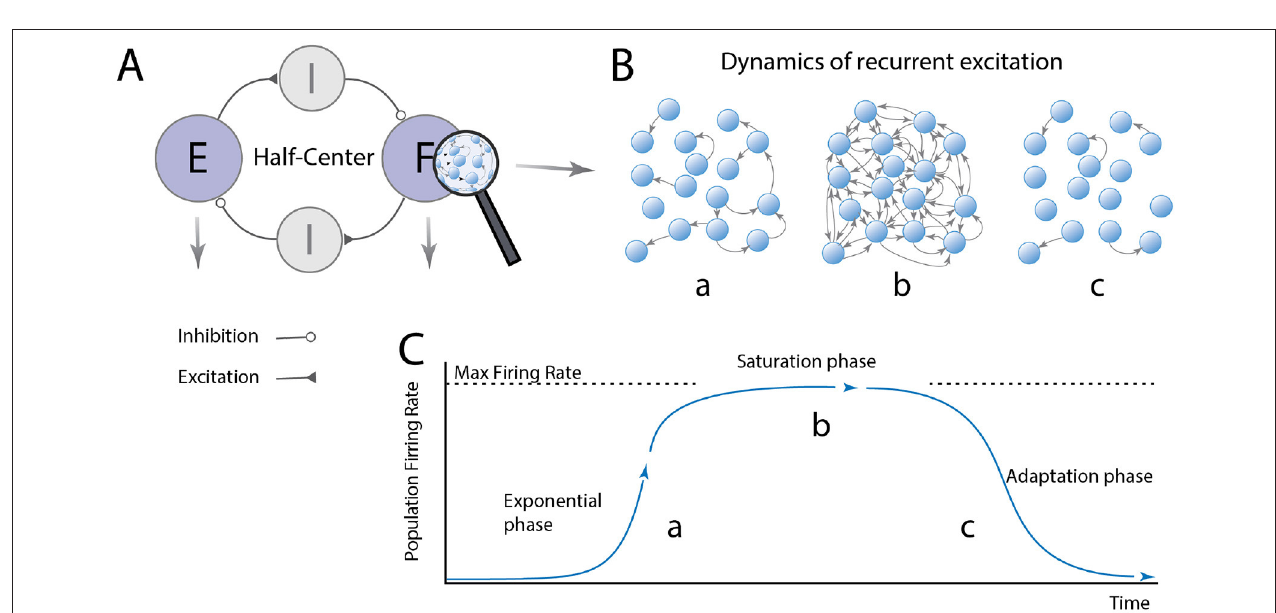
FIGURE 2 | The dynamics of a burst-generator module has 3 phases. (A) The half-center organization consists of modules: flexor (F) and extensor (E) modules, which generate rhythmic bursting activity and these are reciprocally connected via inhibitory modules to ensure F/E alternation. (B,C) The F/E modules are composed of excitatory neurons with pacemaker properties, which are recurrently connected. The module has three phases: (a) When a neuron fire action potentials (arrows) these quickly activate other neurons, since it is supercritical, resulting in an exponential increase in the network activity. More activity leads to more spikes activating more neurons. Once the activity has propagated to the whole network, the neurons reach their max firing rate the network reach saturation (phase b). Shortly there after the adaptation/pacemaker property turns off the firing in the adaptation phase c, and the activity decay back toward quiescence. During the adaptation phase the quiescence also cease the inhibition to the opposite module, allowing a similar cycle to take place there with a delay. Hence, the population alternates between quiescence and maximal firing rates for all the cells in the